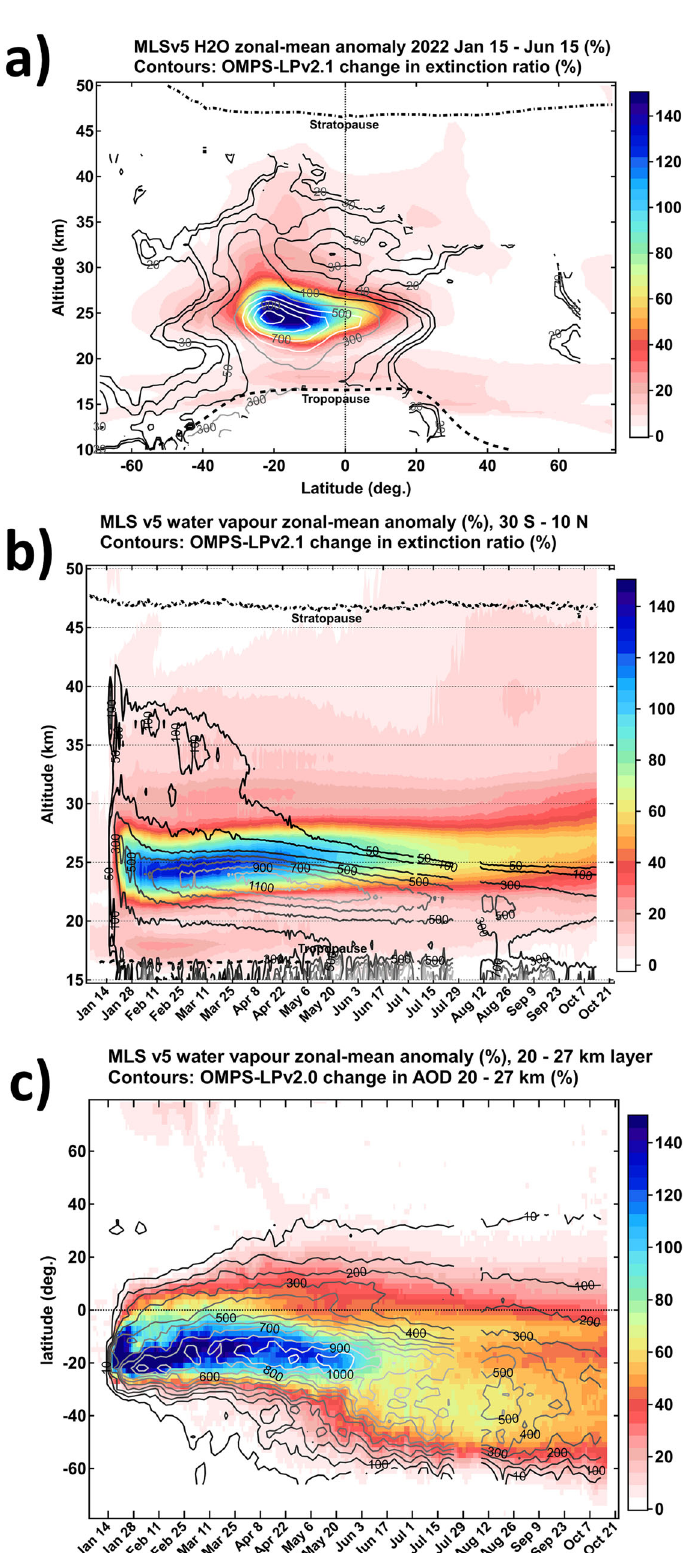
Fig. 7 Spatiotemporal structure of the stratospheric water vapour and aerosol burden perturbation. a MLS V5 zonal-mean WVMR anomaly above 5% averaged over 5 months following the eruption with respect to MLS 17-yr climatology (%, color map) and OMPS-LP extinction ratio anomaly with respect to pre-eruption conditions (%, contours). b Same as A but as a function of time for the latitude band 30° S – 10° N. c Time-latitude variation of WVMR anomaly within 20 – 27 km altitude layer (color map) and change in OMPS-LP AOD with respect to the pre-eruption levels within the same layer (contours).